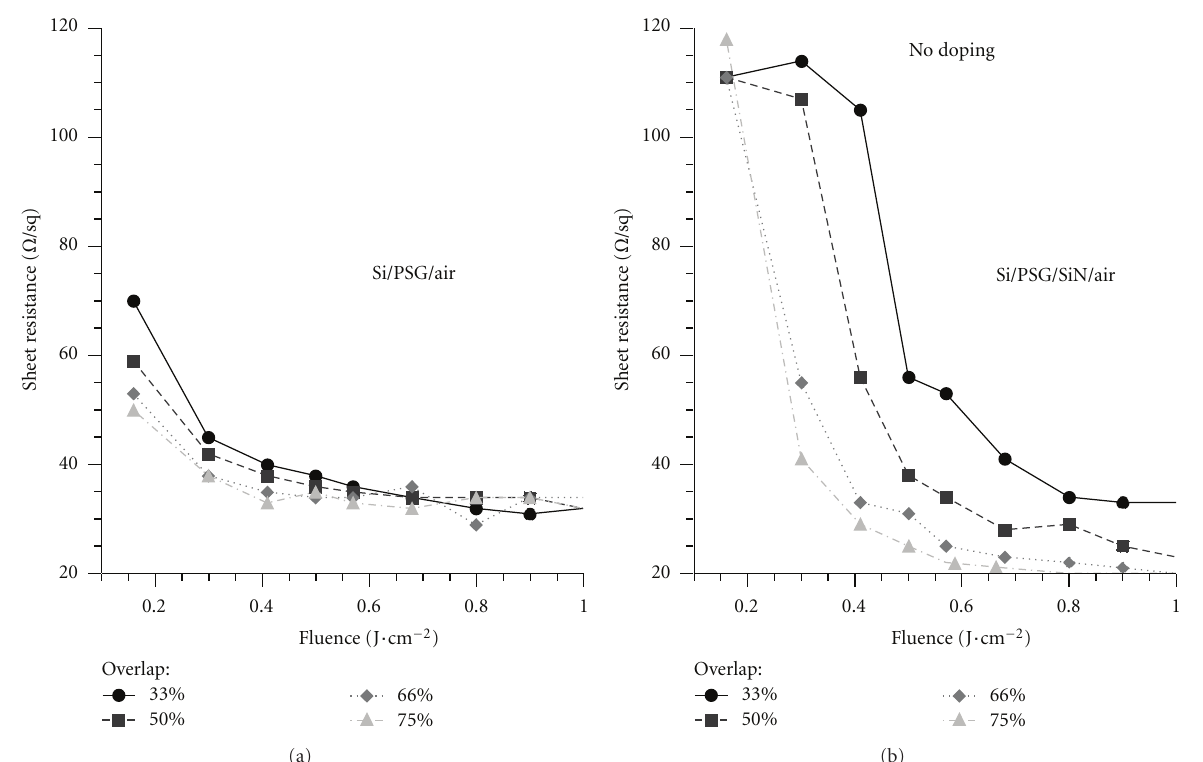
Figure 4: Sheet resistance evolution with laser fluence for 100 Ω /sq initial emitters.